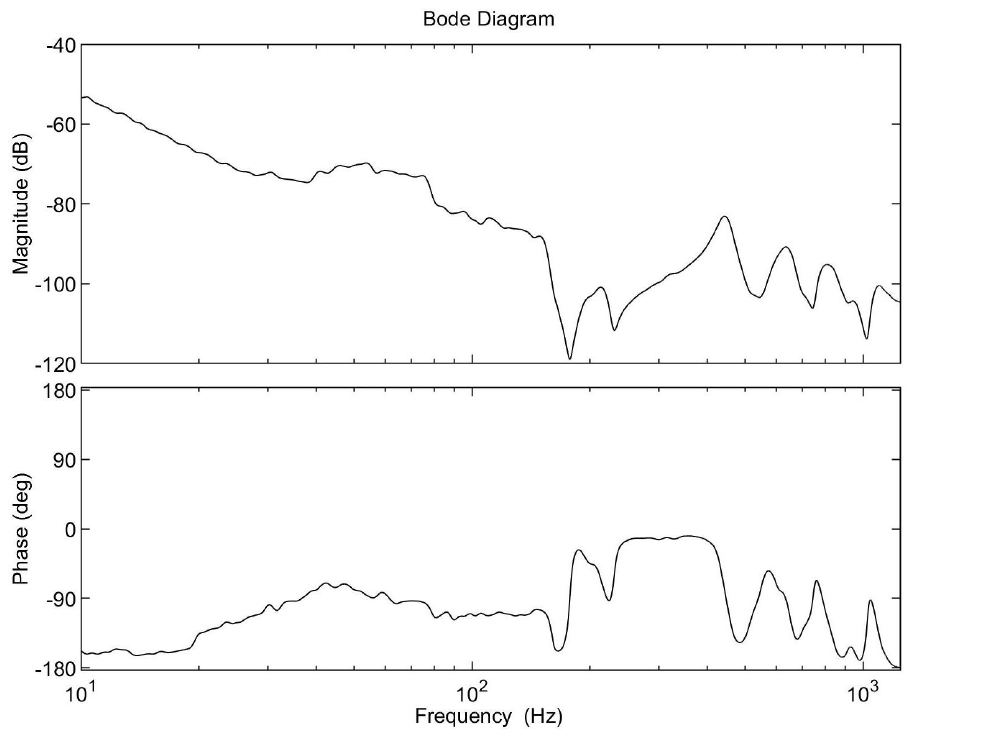
Figure A1. Bode plot of the balanced prototype with motor torque as input and rotary position as